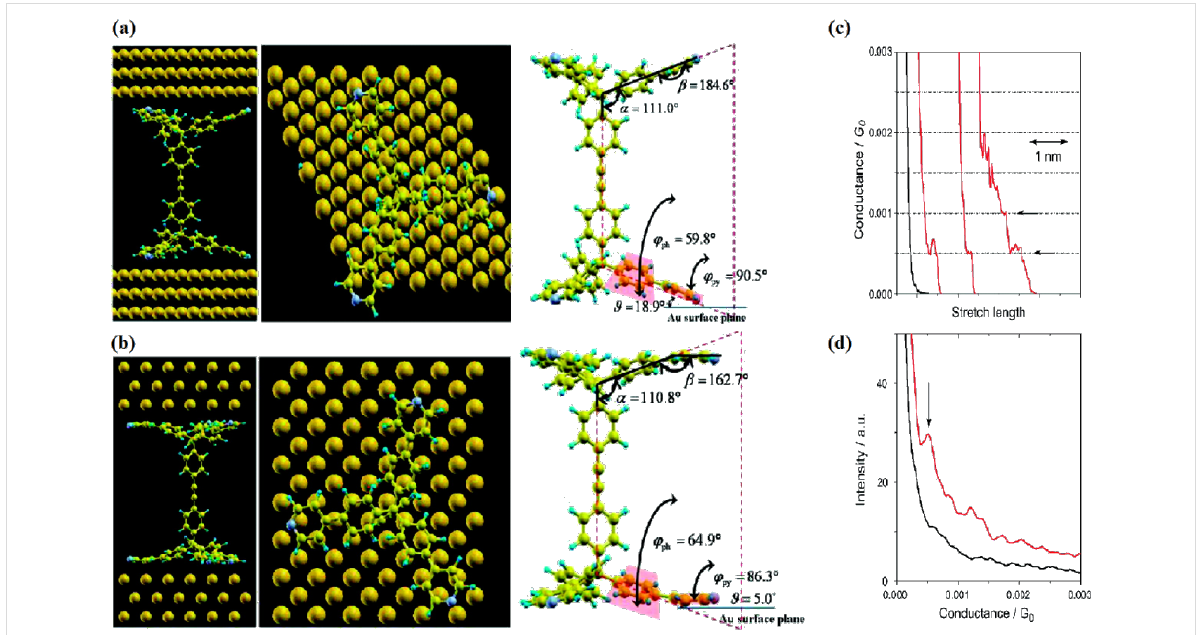
Figure 14: Structures of the junctions used for the ab initio transport calculations, (a) 34 (111) model and (b) 34 (001) model. The left panels show side views of each system, whereas the middle panels show views from the top. The right panels give the details of the parameters to identify the con- formation for 34 platform, such as dihedral and bending angles. (c) Conductance traces measured when breaking the Au point contacts in solutions with (red) and without (black) 34 . (d) Corresponding conductance histograms constructed without data selection from 1000 traces. Each histogram is normalized by the number of traces used to construct the histogram. The bin size is 10 − 5 G 0 . Reprinted with permission from [35], copyright 2011 American Chemical Society.